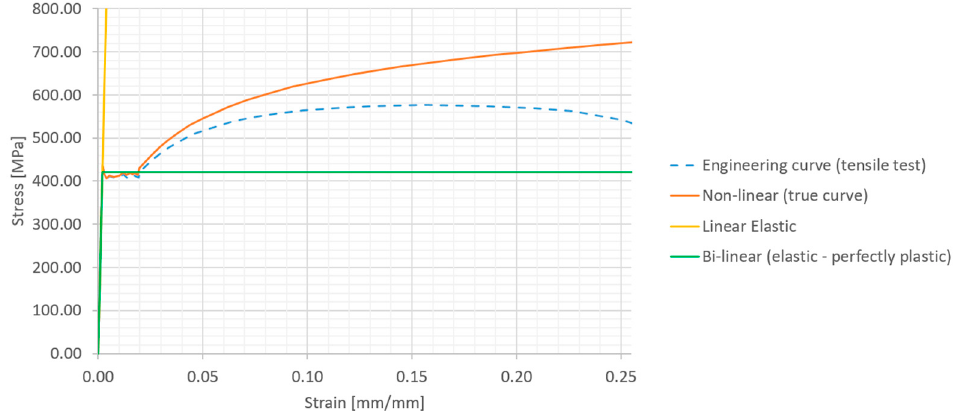
Figure 3. Diagram of a pinned–fixed column under compression.